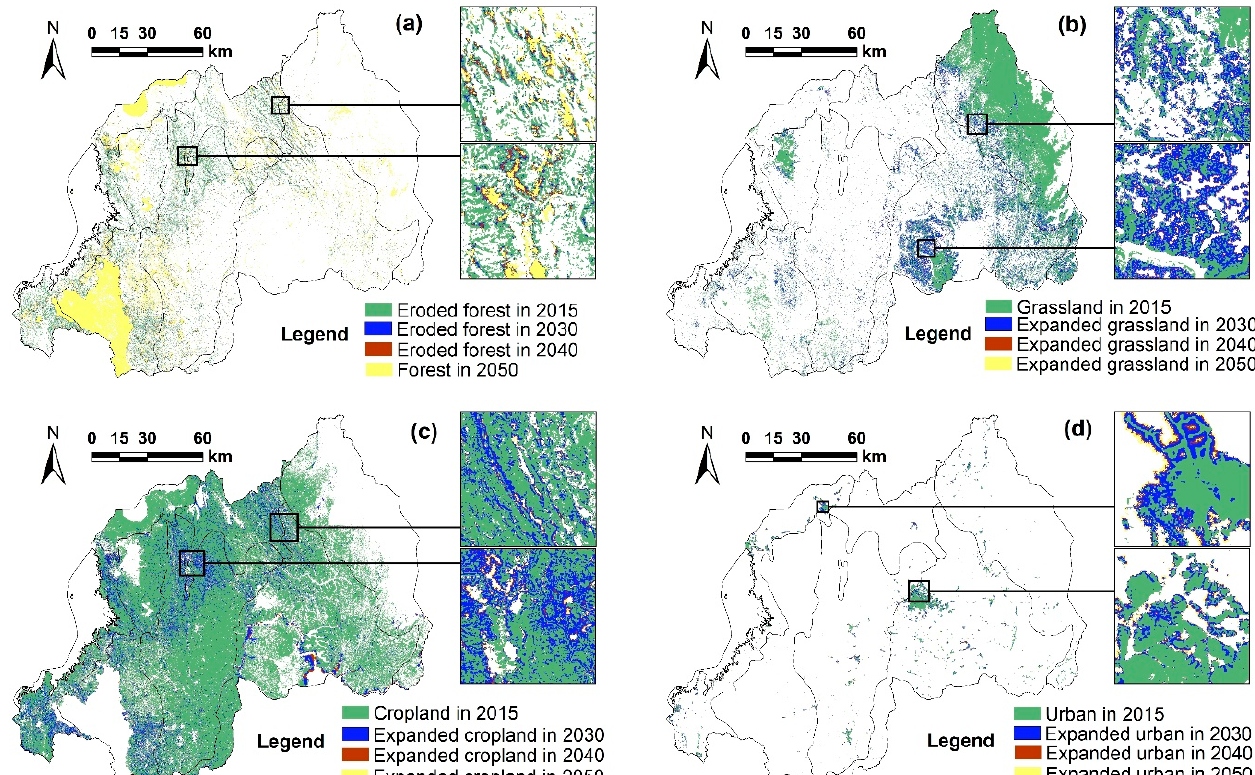
Figure 8. Land expansion maps for ( a ) forest; ( b ) grassland; ( c ) cropland; and ( d ) urban land. Overall, over the next 30 years, most of the areas of forest loss in Rwanda were projected to be located on either side of the Congo/Nile watershed in the western part of the country and in the VH region in the north. The increase in grassland was projected to occur primarily in the eastern ES and EP regions. The increase in cropland was mainly projected to occur in the BH, PC, and CNC regions in the northwest.